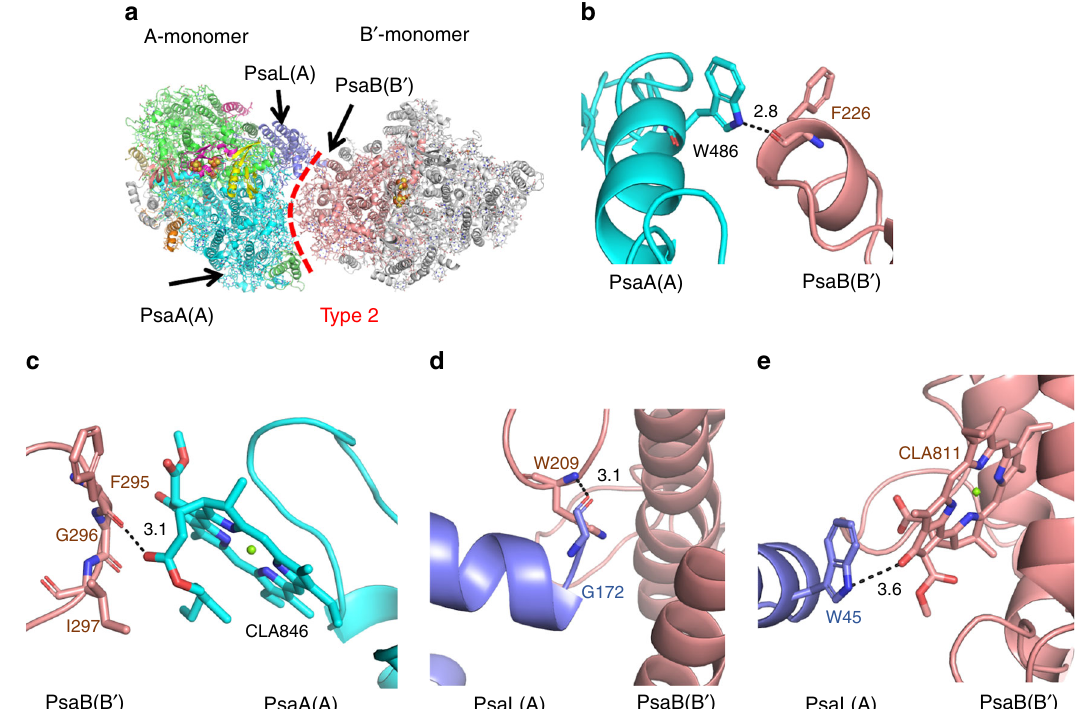
Fig. 4 Interactions at the Type 2 interface. a Structure of a dimer unit (dimer A-B ′ ) from a PSI tetramer viewed along the membrane normal from the stromal side. b , c Interactions between PsaA (A) and PsaB (B ′ ). d , e Interactions between PsaL (A) and PsaB (B ′ PsaL (B) (Fig. 3f, some of the numbering of pigments and other cofactors discussed in the text are different from those regis- tered in the PDB fi le; for a complete correspondence of the numbering of pigments and cofactors in the text with those in the PDB fi le, refer to Supplementary Tables 3).